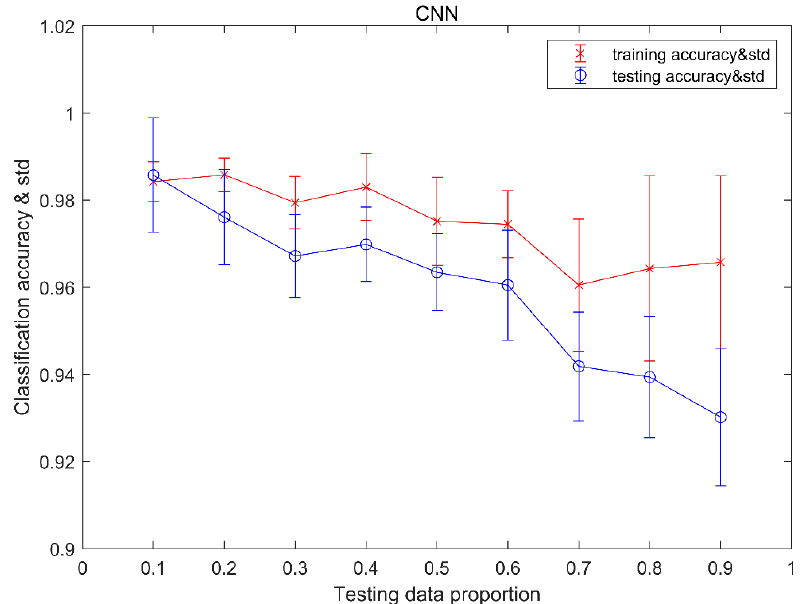
Figure 6. The classification accuracy and the standard deviation of CNN.